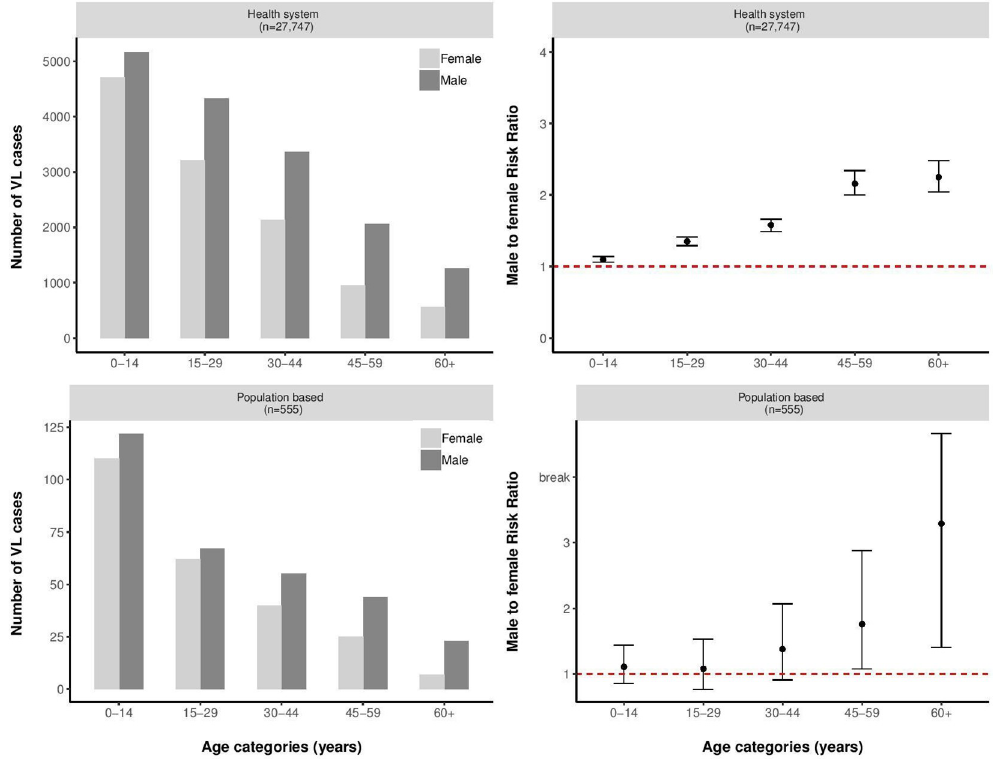
Fig 1. Absolute number of patients per sex and age group, and male to female ratio per age group of patients with visceral leishmaniasis reported through the health systems (Bihar and Jharkhand, India (2014–2017; n = 26,845), and Nepal (2014–2017; n = 902)) and through population-based studies (Kalanet (2006–2009; n = 109) and TMRC (2007 (2012 for ‘new area’)– 2015; n =